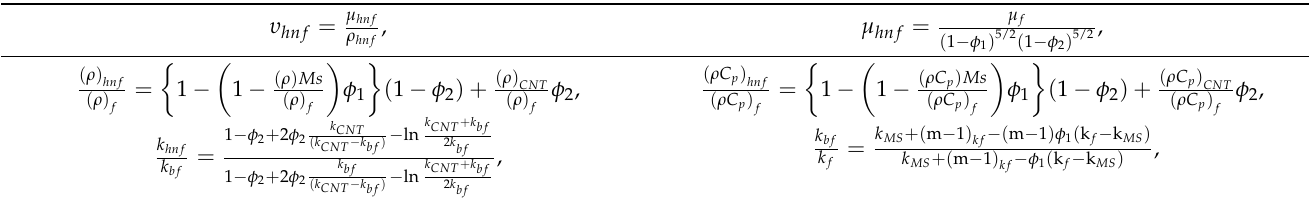
Table 1. The thermophysical properties of base fluid and hybrid nanofluid.